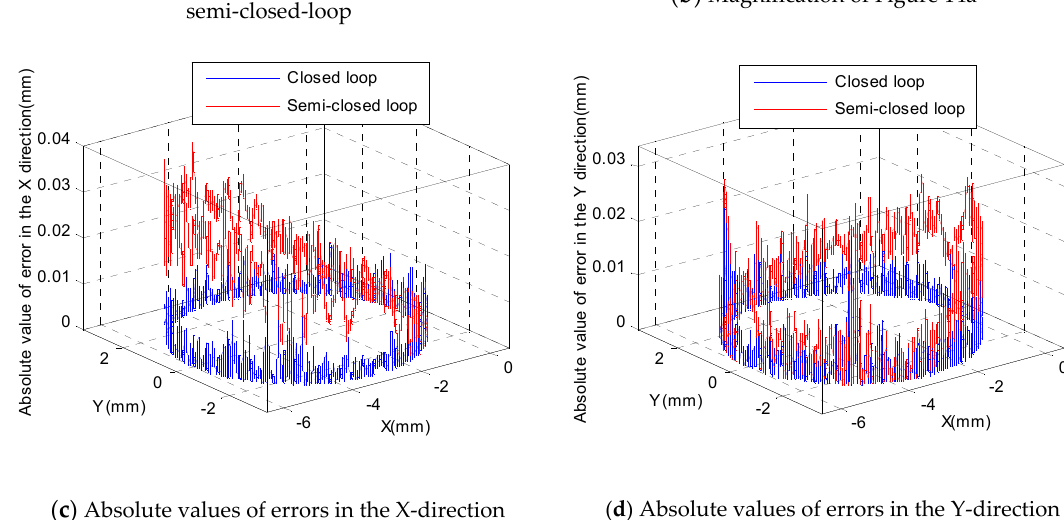
Figure 14. Circular trajectory tracking with a PI controller, 0.5, 0.1